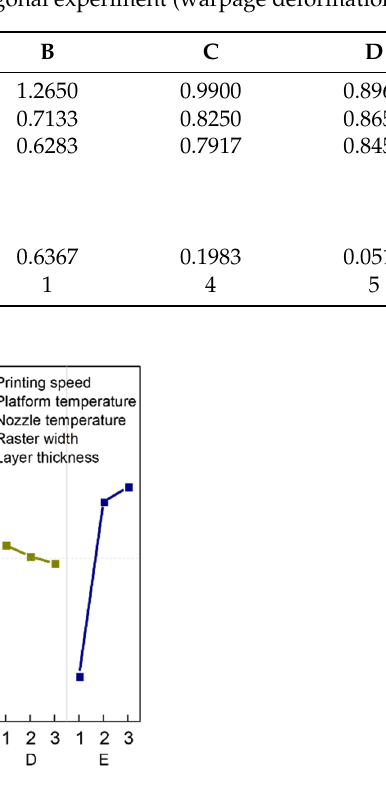
Figure 5. Main effects plot: relationship between warpage and factors with different levels.